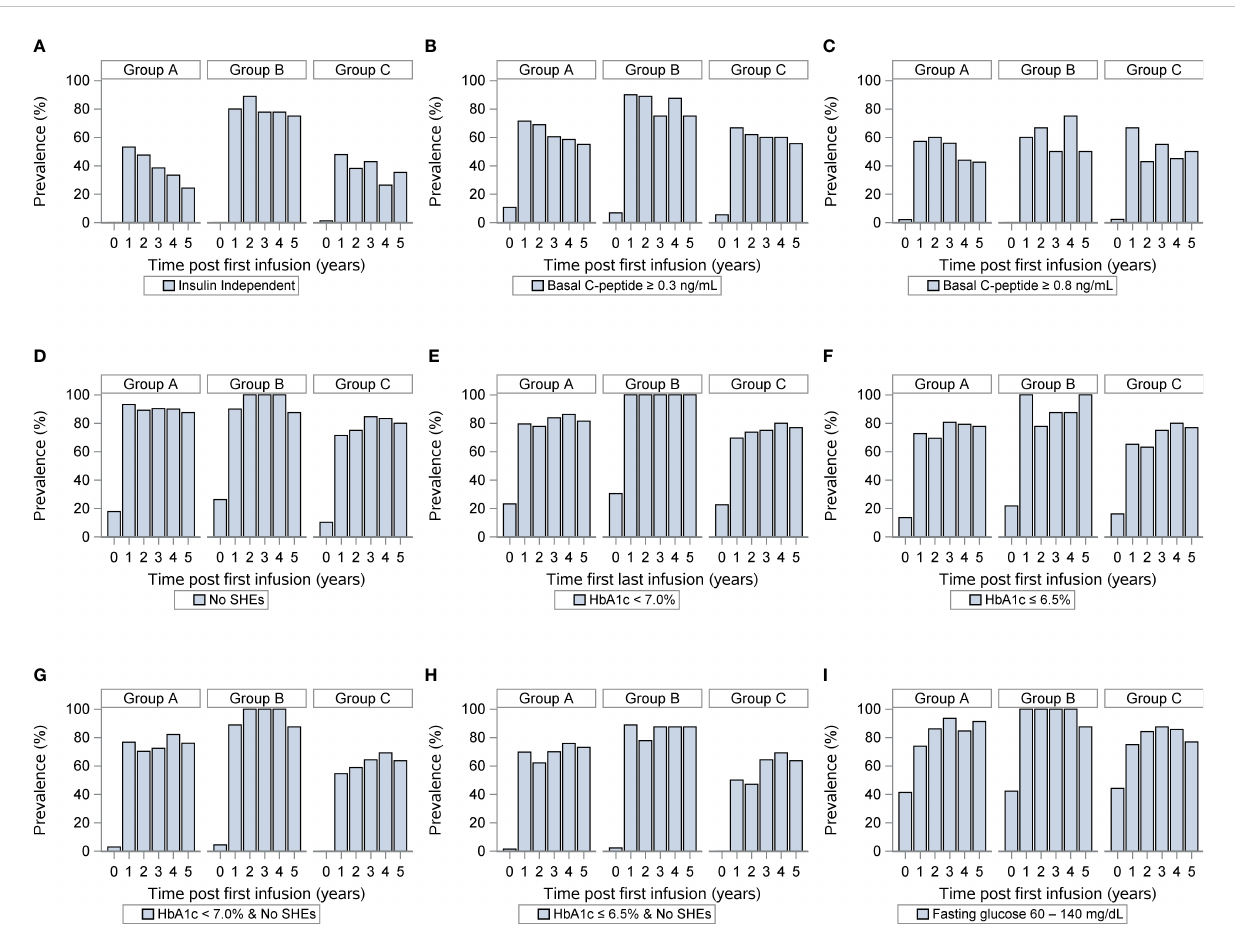
FIGURE 2 Outcomes of islet transplantation alone with complete HLA-DR data. Insulin independence (A) , basal C-peptide ≥ 0.3 ng/mL (B) , basal C-peptide ≥ 0.8 ng/mL (C) , absence of severe hypoglycemic events (D) , HbA1c <7% (E) , HbA1c ≤ 6.5% (F) , absence of severe hypoglycemic events and HbA1c < 7.0% (G) , absence of severe hypoglycemic events and HbA1c < 6.5% (H) , fasting blood glucose 60-140 (mg/dL) (I) in group A (HLA-DR mismatches) group B (one or two HLA DR matches, excluding HLA-DR3 and HLA-DR4) and group C (HLA-DR3 or HLA-DR4 match). For each panel, the fi rst row indicates years after islet transplantation; the second the percentage with outcome; the third the number of